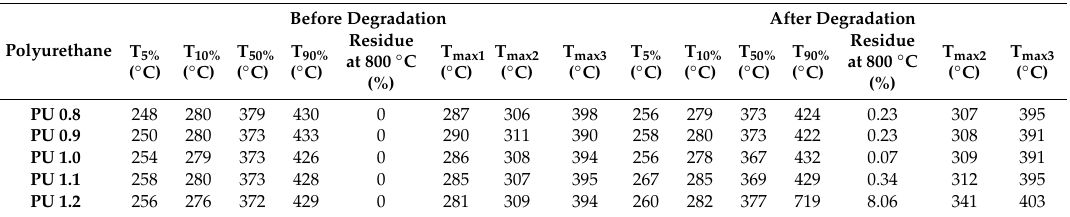
Table 4. Thermal analysis of polyurethanes produced by di ff erent isocyanate indices before and after enzymatic degradation